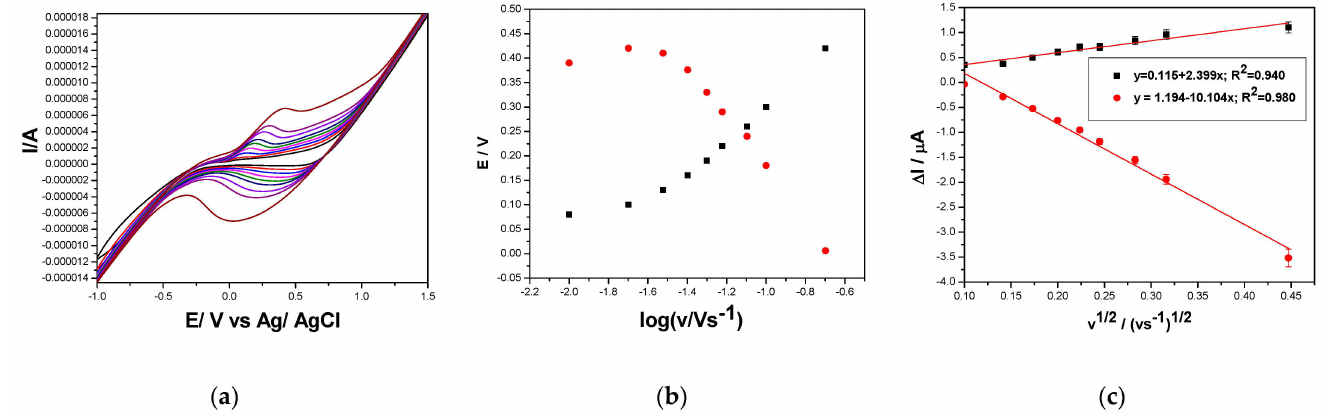
Figure 6. ( a ) Cyclic voltammograms recorded in 5 mg · L − 1 DOX and 0.1 M NaOH supporting electrolyte with the Cu/GRQD/CNT paste electrode at various scan rates: (curve 1) 10, (curve 2) 20, (curve 3) 30, (curve 4) 40, (curve 5) 50, (curve 6) 60, (curve 7) 80, (curve 8) 100, and (curve 9) 200 mV · s − 1 ; ( b ) Dependence of peak potential vs. logarithm of the scan rate. ( c ) Dependence of anodic and cathodic peaks current vs. square root of the scan rate.